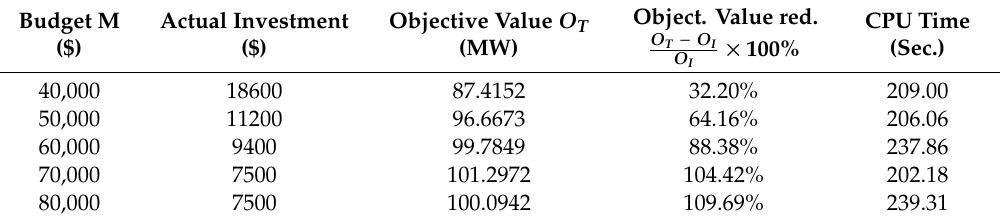
Table 8. Results on the IEEE 118-bus system using the TS.